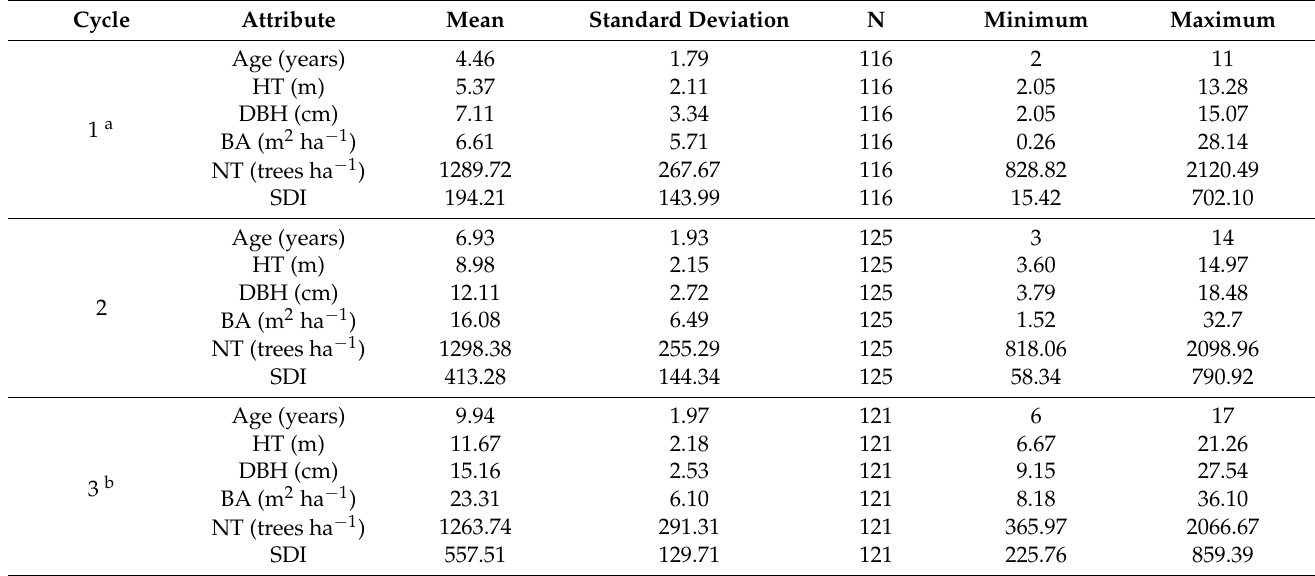
Table 1. Summary statistics of field reference data by